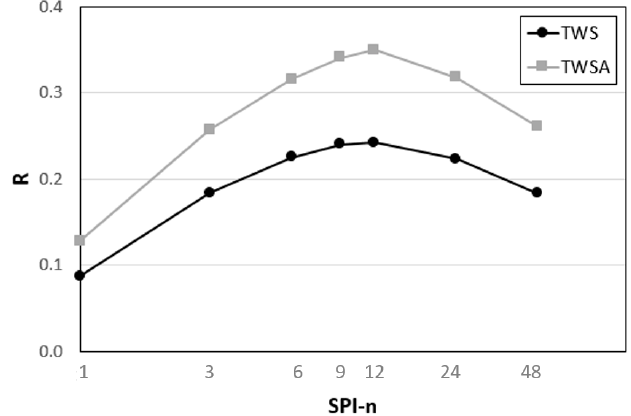
Figure 1. Global-average R between di ff erent SPI-n vs. TWS (black line with circles) and TWSA (grey line with squares).